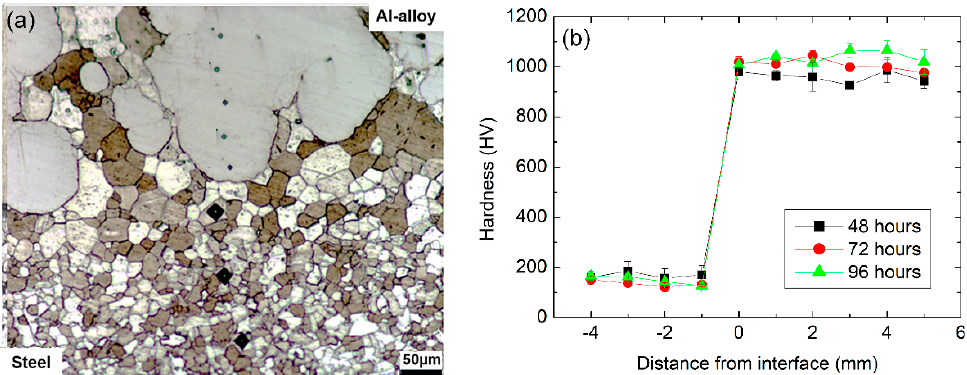
Figure 4. Cross-section analysis after heat-treatment at 550 °C: microstructure at the substrate/coating interface of a sample treated for 96 h ( a ) and microhardness profiles according to heat treatment time ( b ).